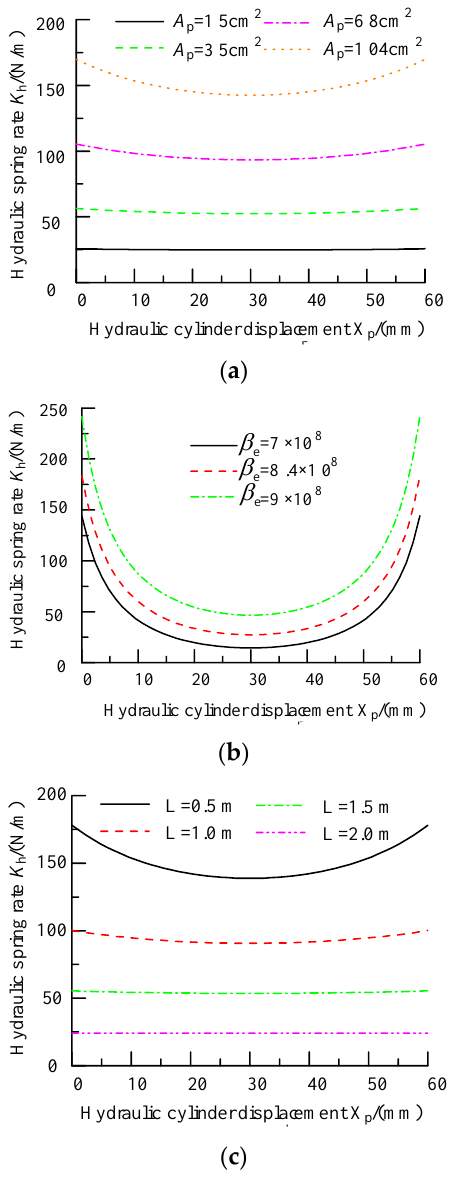
Figure 7. Simulation diagram of hydraulic spring stiffness characteristics: ( a ) Simulation curve of hydraulic spring stiffness and hydraulic cylinder area; ( b ) simulation curve of hydraulic spring stiffness and bulk elastic modulus; and ( c ) simulation curve of hydraulic spring stiffness and pipeline length.